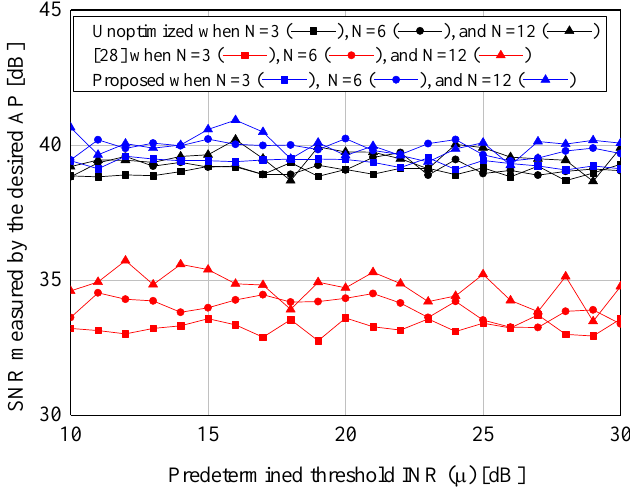
(cid:0) (cid:1) ϑ opt , Γ 1